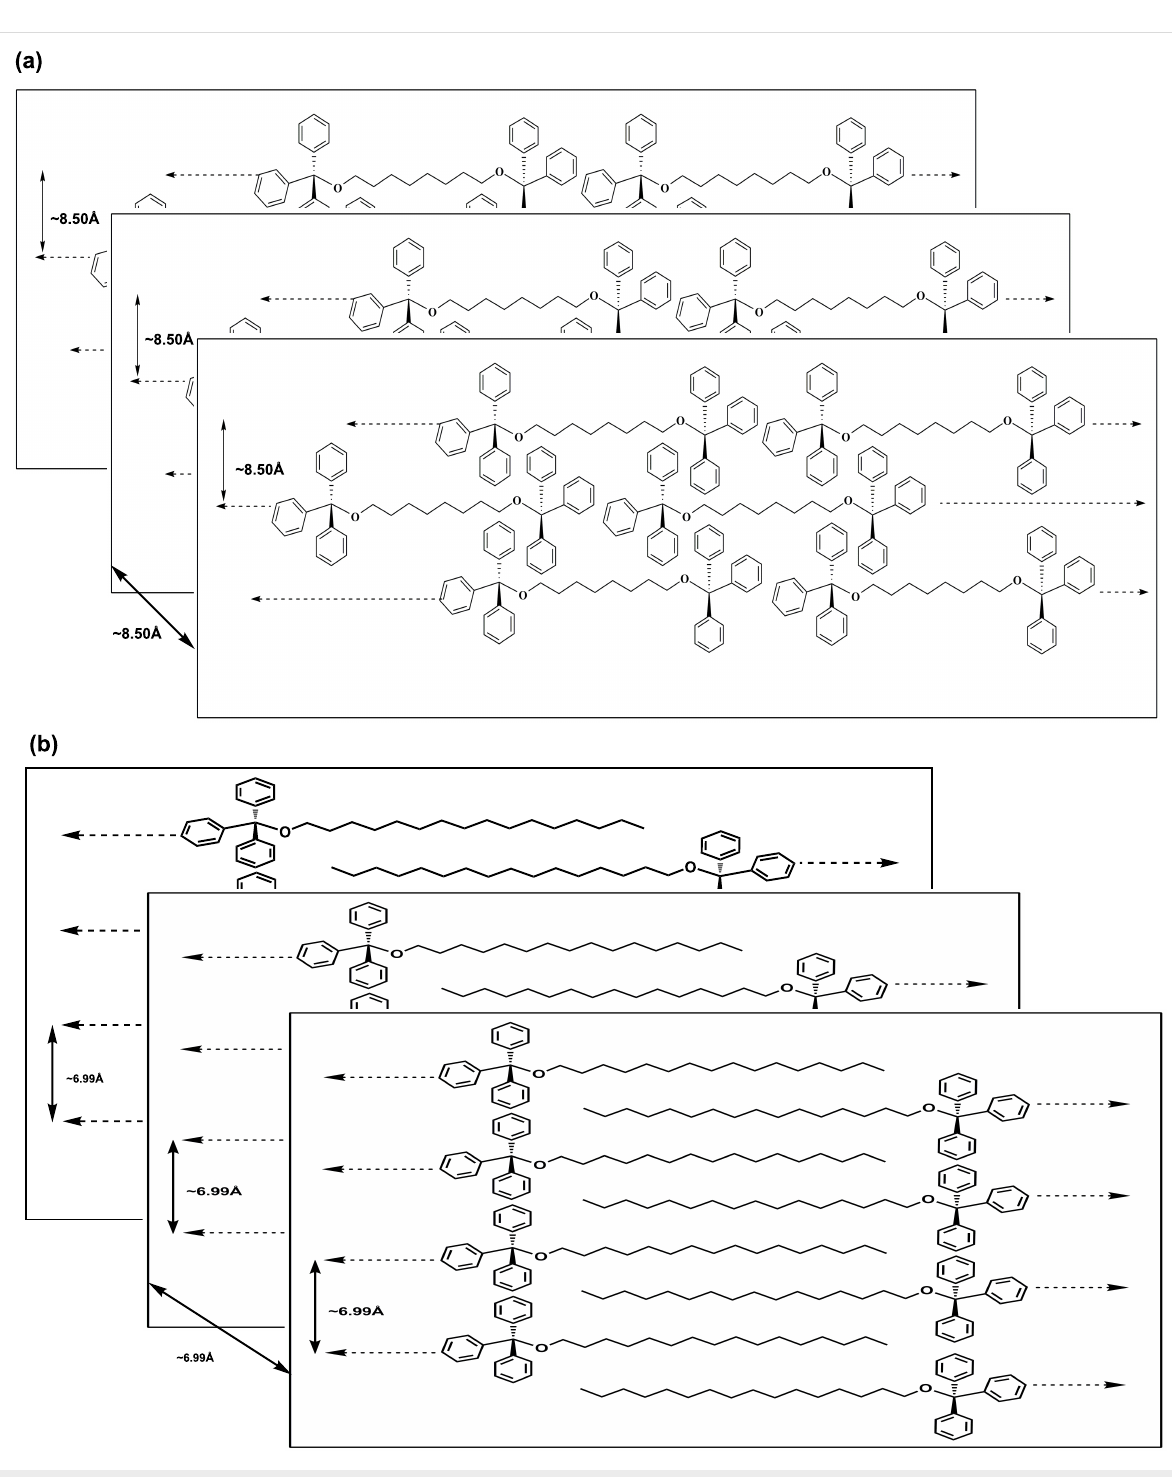
For TPM-G5 , two high-intensity peaks at 9.56° (2 θ value) and 12.75°, and two low-intensity peaks at 19.17° and 22.39° were observed (Figure 7b). The d-spacing values are 9.24 Å, 6.93 Å, 4.62 Å and 3.96 Å, respectively. Figure 8b shows the energy